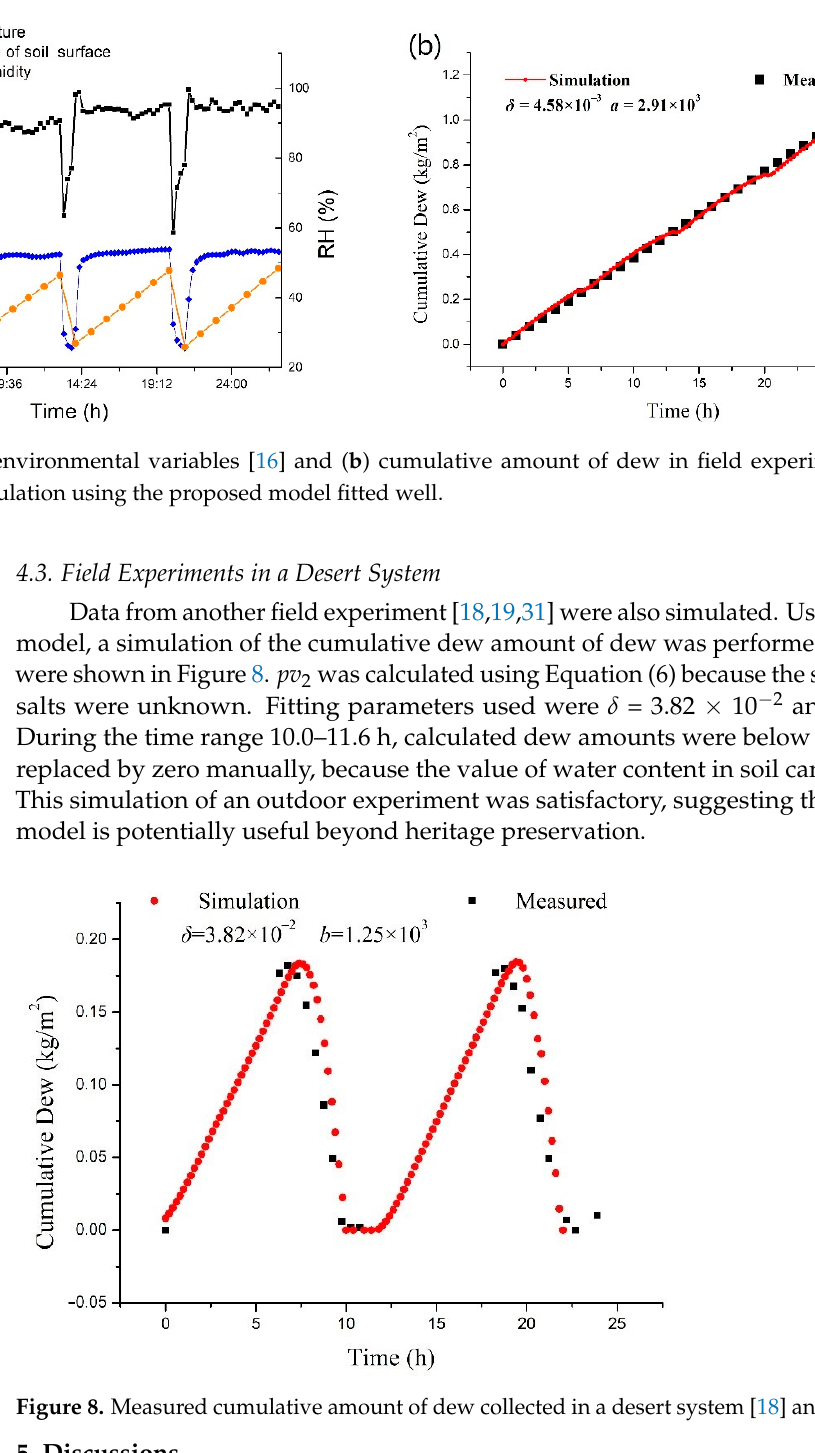
Table 2. Statistical analysis results with a significance level of 0.05. δ e values in numerical simulations were not statistically different from δ in model fitting. Phase Ⅰ